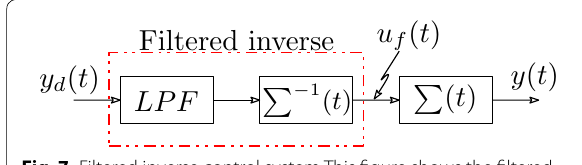
Fig. 7 Filtered inverse control system This figure shows the filtered inverse control system comprising of the filter, the inverse controller and the